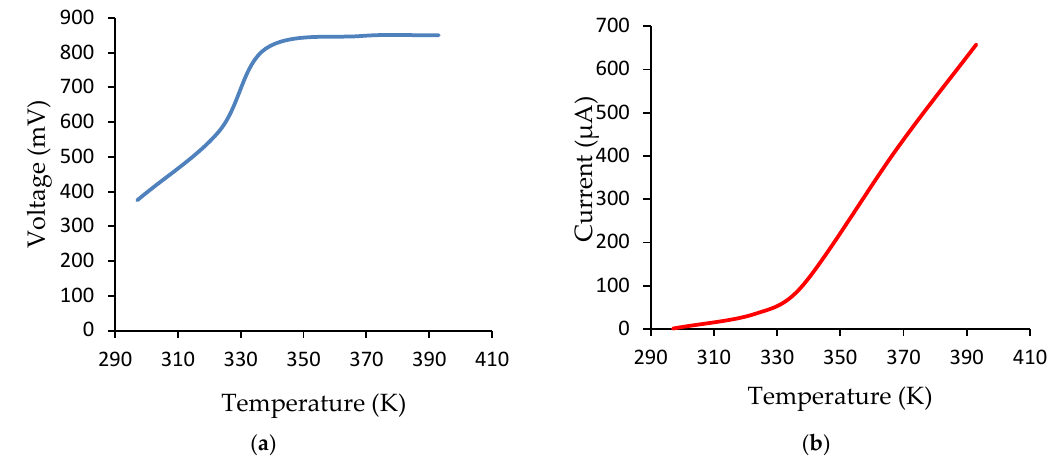
Figure 3. Schematic representation of the mode of operation of the thermoelectric generator. The temperature of the graphite plate was increased from 297 to 393 K, and at the same time, the voltage and the output current were measured. The graphic representation of the voltage and current variation as a function of temperature can be seen in Figure 4.